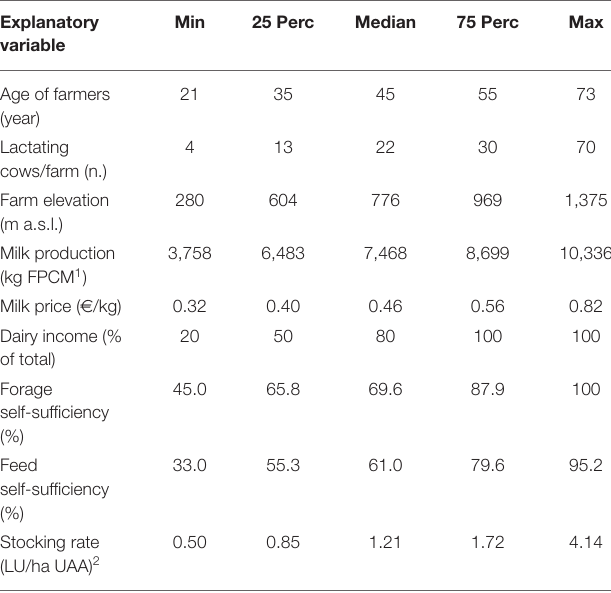
TABLE 2 | Prevalence of ABMs observed or retrieved from farm records in 69 mountain dairy farms.